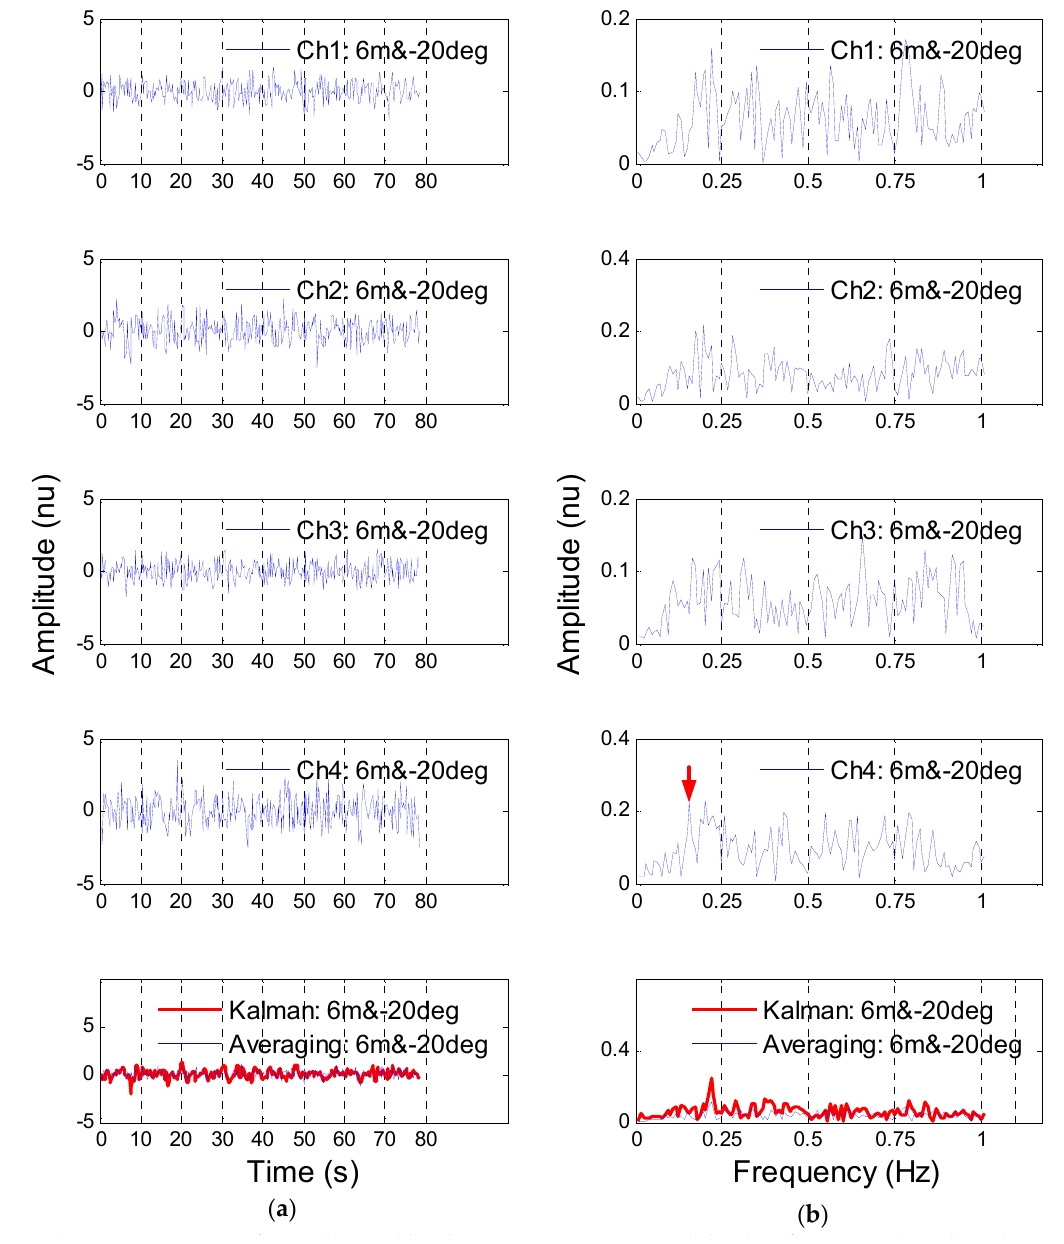
Figure 10. Four waveforms detected by the target association and the data fusion result and ( a ) their corresponding power spectrum in the frequency domain ( b ) when the volunteer was measured at the position (6 m, − 20°). The rows from top to bottom were the waveforms from channel 1, 2, 3, 4 and the detected respiration, respectively. The detected respiration was fused by two methods: one is the Kalman filtering proposed in this paper and the other is a simple method based on averaging all four waveforms.